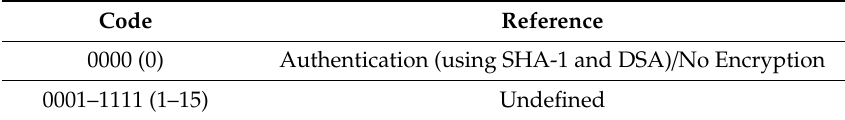
Table 1. Security parameter information type codes.